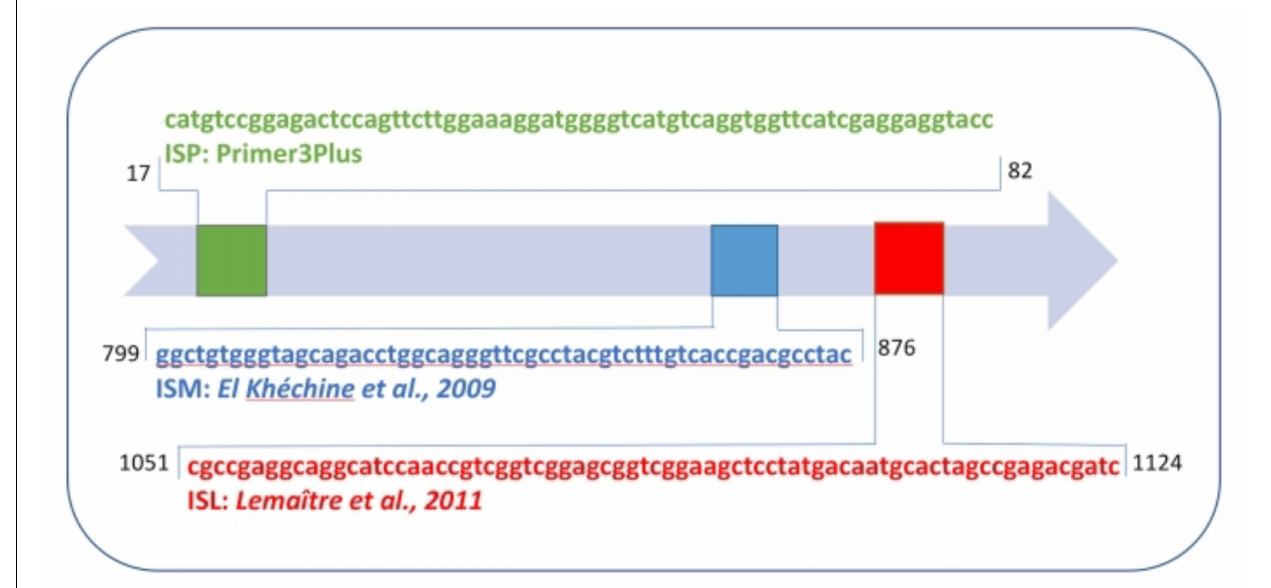
FIGURE 1 | Schematic representation of IS6110 sequence and primer-probe sets of ISP, ISM, and ISL.